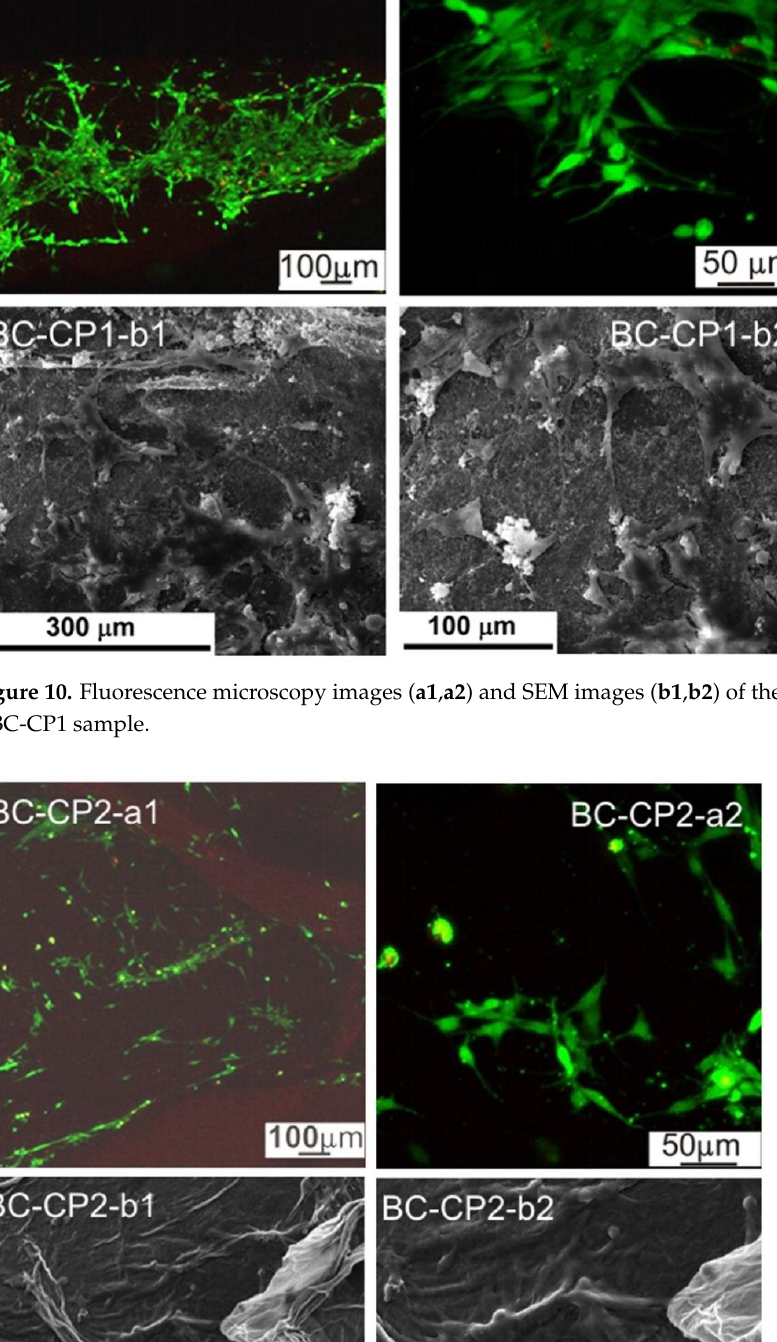
Figure 12 . Fluorescence microscopy images ( a1 , a2 ) and SEM images ( b1 , b2 ) of the adherent cells in a DABC sample.